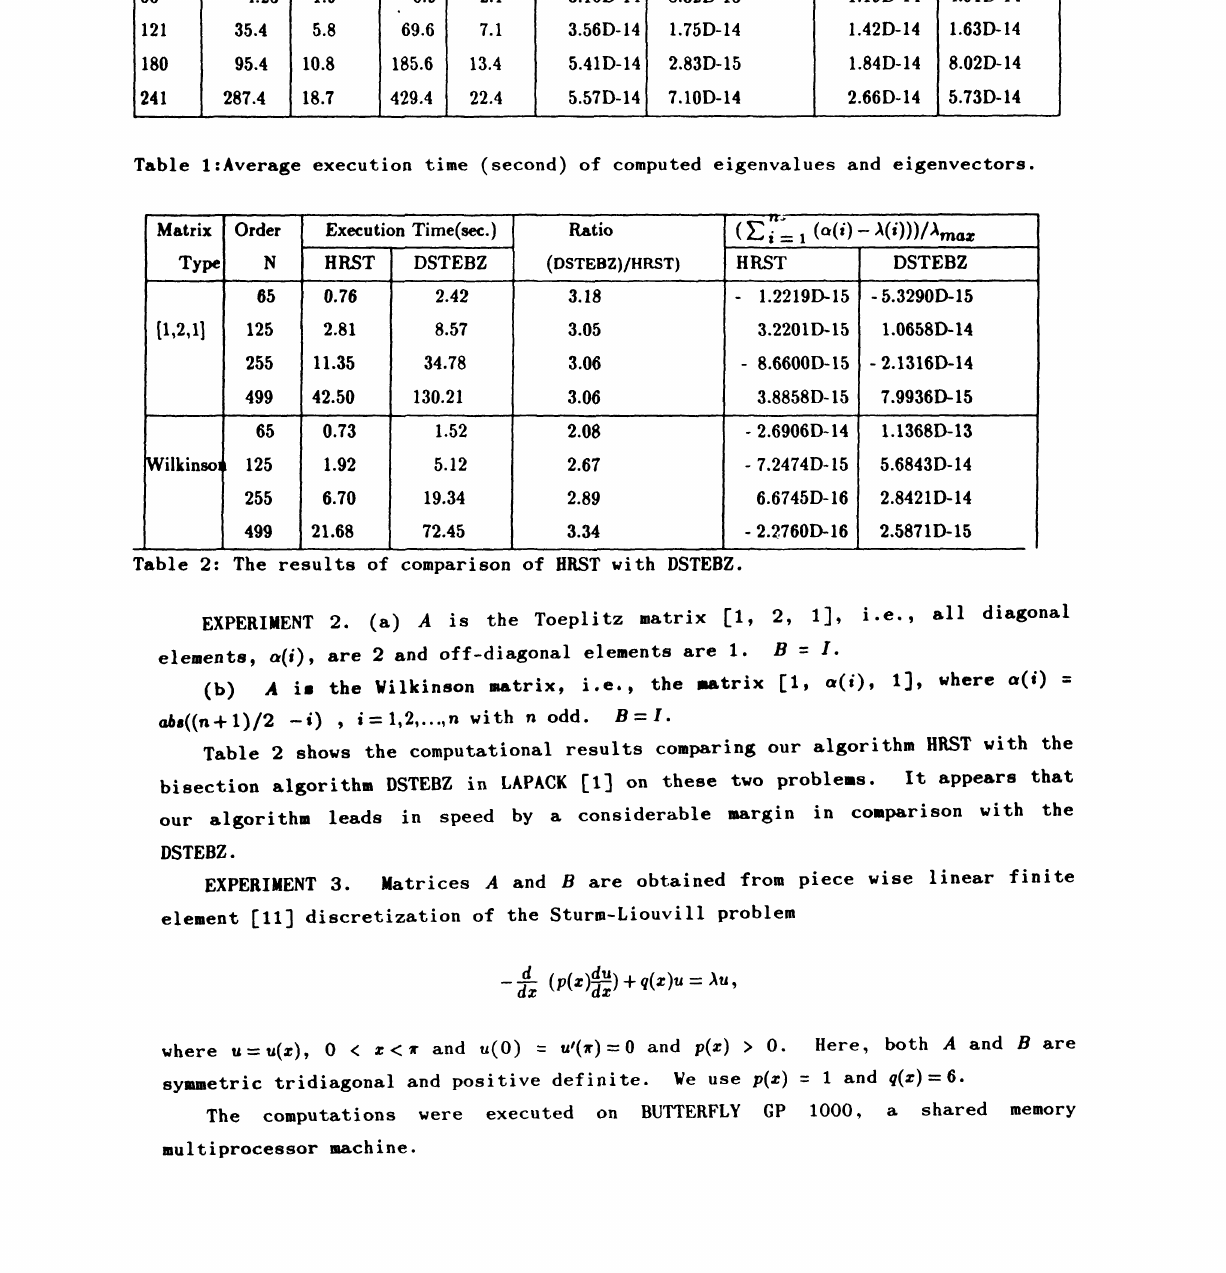
Table l:Average execution time (second) of computed eigenvalues and eigenvectors. Matrix Order Execution Time(sec.)